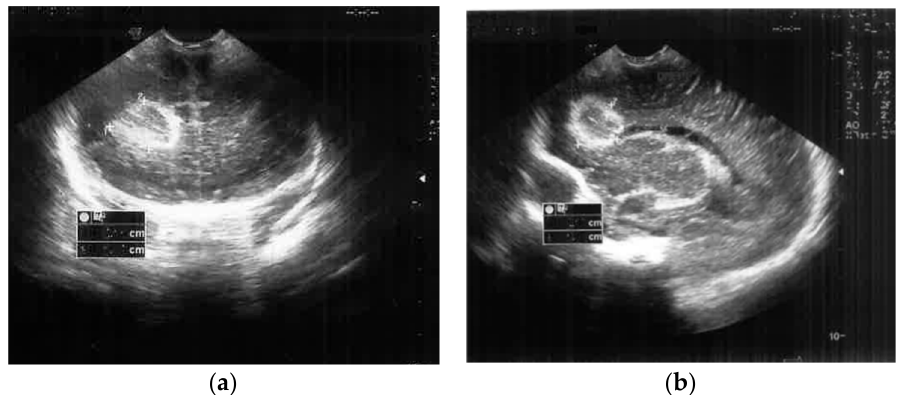
Figure 1. Brain ultrasound on the second day of life (( a ) Frontal coronal plan, ( b ) right parasagittal plan) showed a nodular frontal lobe lesion with a hyperechoic demarcation line.